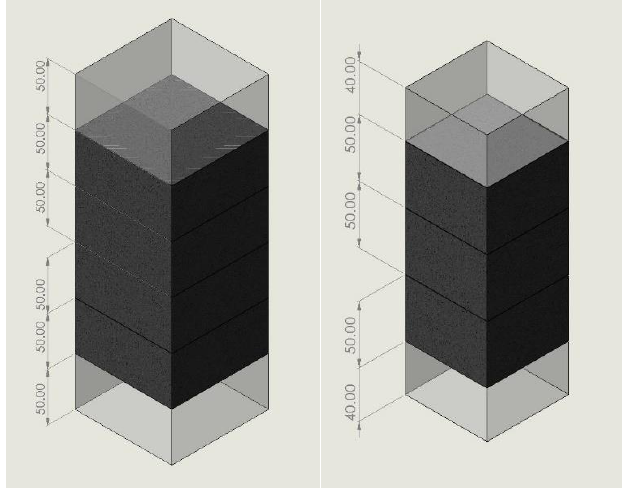
Figure 2. Cutting methods for undamaged concrete ( left ) and cement paste and mortar ( right ) specimens (unit: mm).